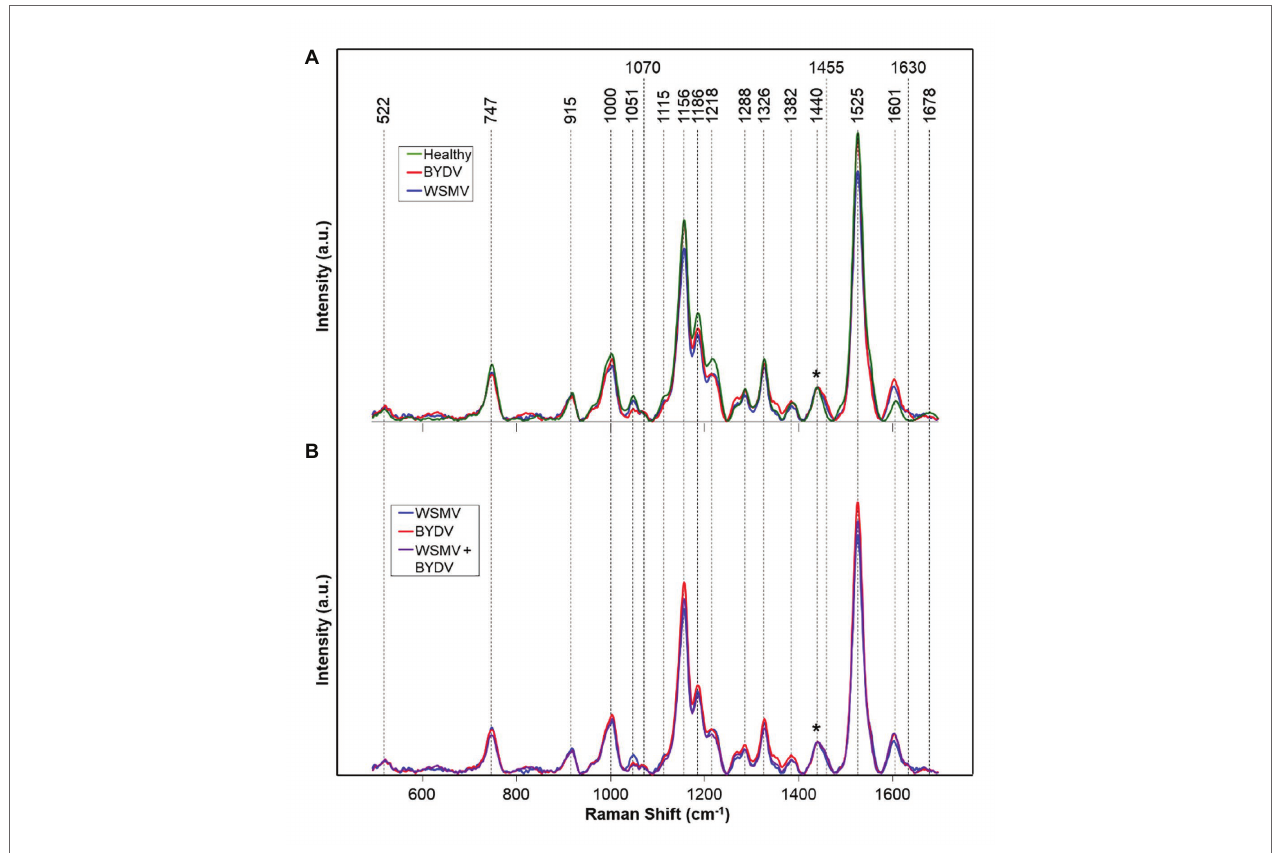
FIGURE 6 | Raman spectra of: (A) Healthy and WSMV- or BYDV-infected wheat leaves and (B) the combination of these two viruses. Normalization band at 1,440 cm −1 is marked by an asterisk